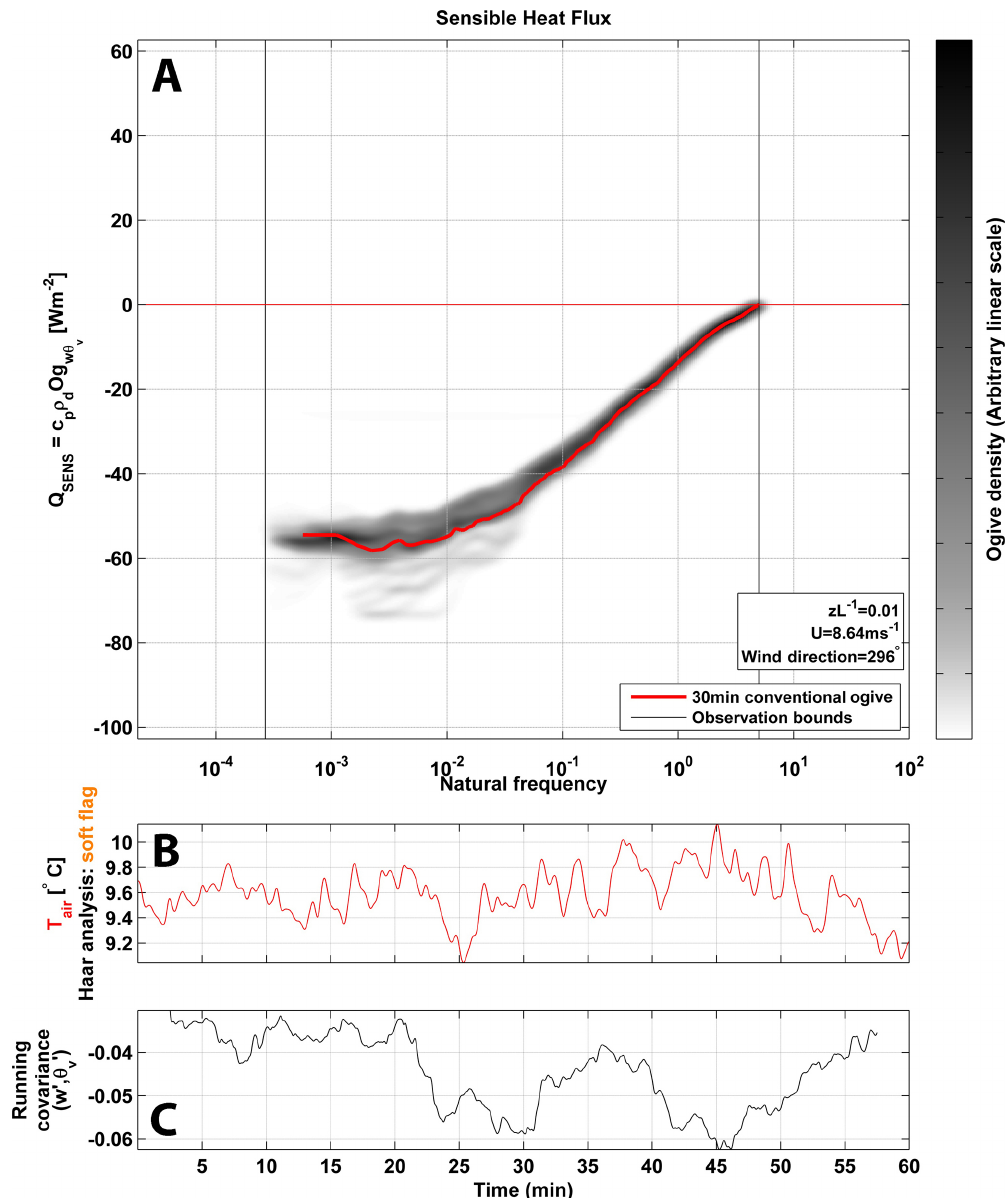
Figure 2. (a) Density pattern of 10000 individual ogive flux distributions following data perturbation of flux averaging time and running mean detrending for a 60min observation from Abisko on the 2nd of July 2012 at 7:45p.m. LT. The standard 30min linear detrending is shown in red and atmospheric stability, mean wind speed and wind origin (clockwise) are given in the bottom right. Also shown are (b) a smoothed raw atmospheric temperature signal (red line) and (c) a running covariance (5min window, linear detrending) between w (cid:48) and θ v (cid:48)